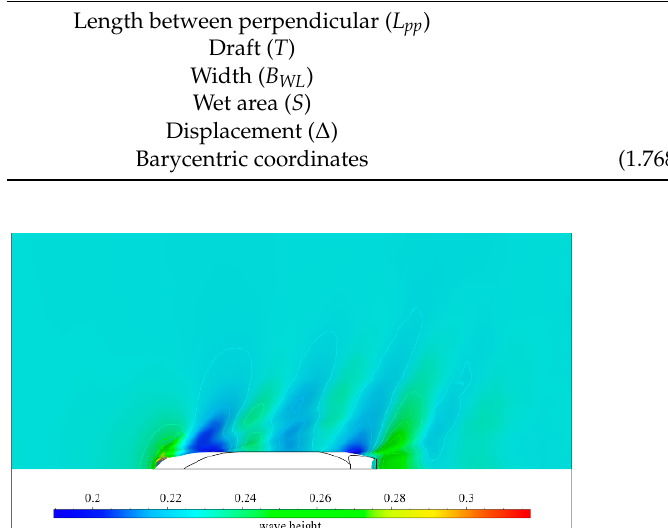
Figure 7. Water surface wave height. Table 9. Main parameters of traditional icebreaker ship model (scale ratio α = 40).